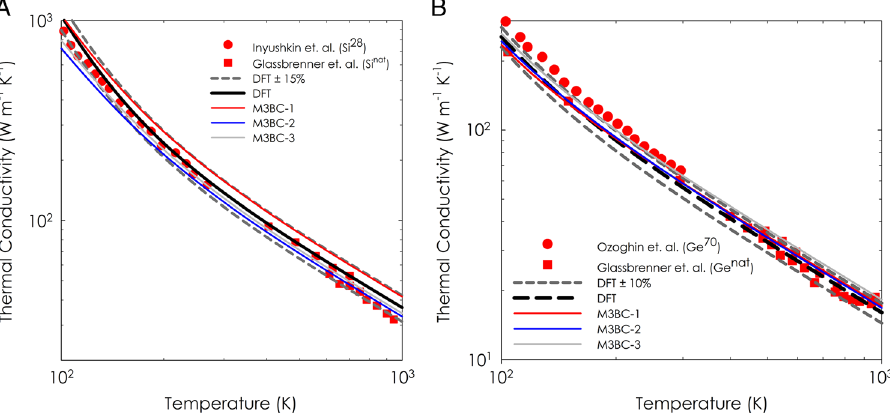
Fig. 4 M3BC, DFT, and experimental 59, 60 thermal conductivity vs. temperature. a Thermal conductivity as a function of temperature for c-Si with DFT, experimental, 59, 60 and M3BC POPs. b Thermal conductivity as a function of temperature for c-Ge with DFT, experimental, 59, 61 and M3BC POPs. While M3BC-3 is within 10% of the DFT thermal conductivity for c-Si, other M3BC potentials were not able to reach this mark. DFT thermal conductivity ± 15% is therefore displayed to show the performance of the M3BC potential for c-Si